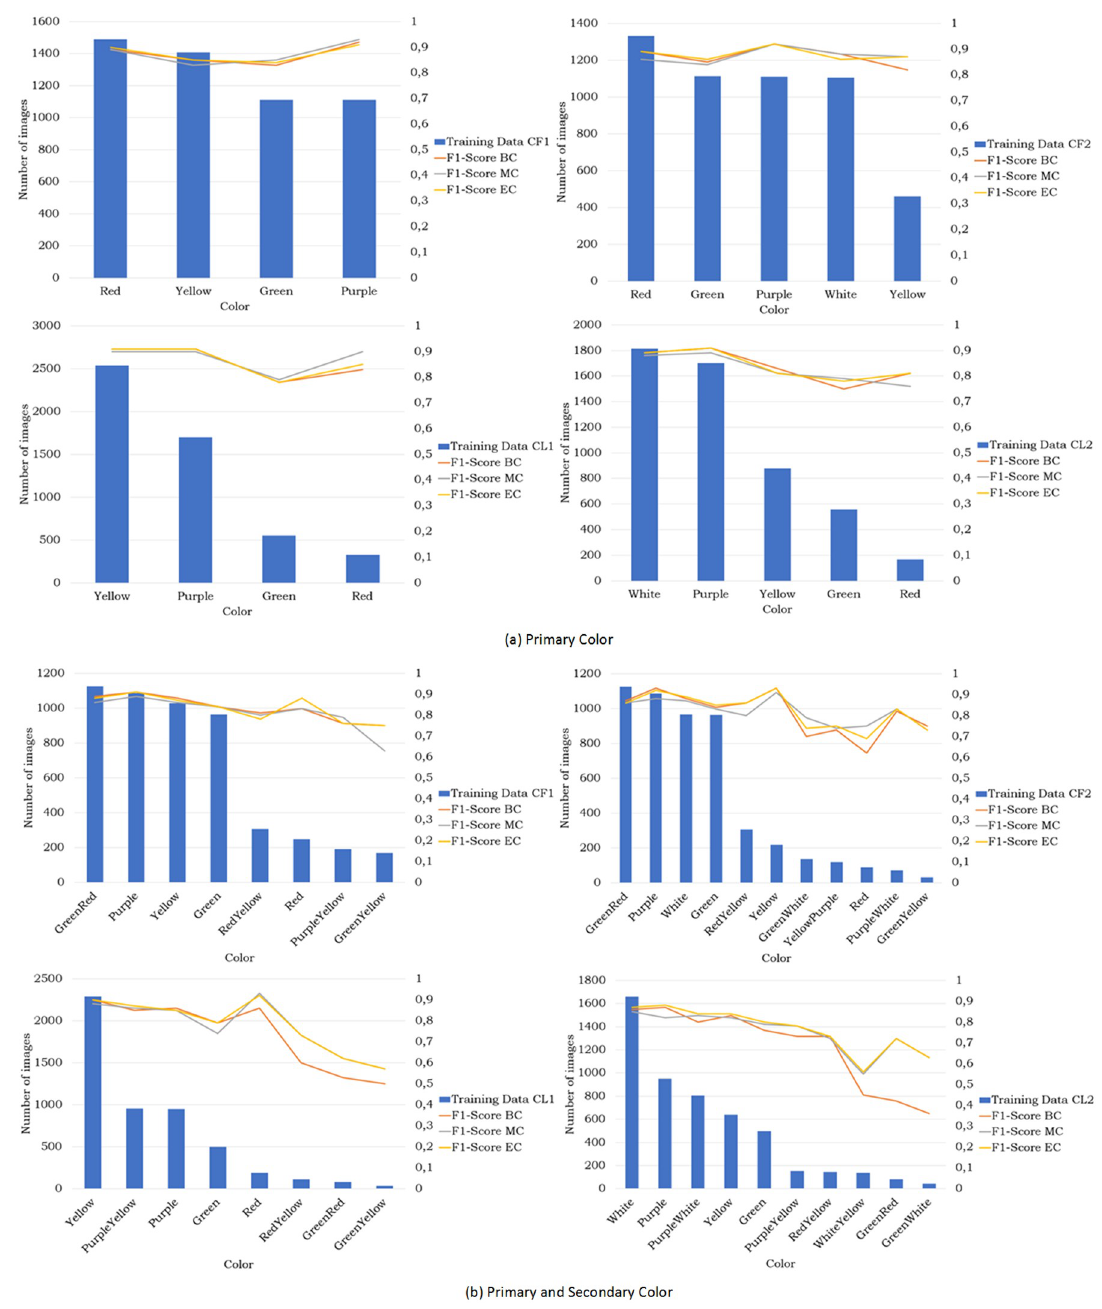
Fig 10. Number of images for each color related to the F 1 -score of the various classifiers. scheme 1, whereas it is ‘White’ for color scheme 2. For both color schemes, these colors are often predicted as ‘Green’. The other confusion matrices are provided in the supplement S1 Fig. It is worthwhile to examine the images used in testing in more detail to understand why the classifiers often achieved a good performance and sometimes also failed. As a consequence,